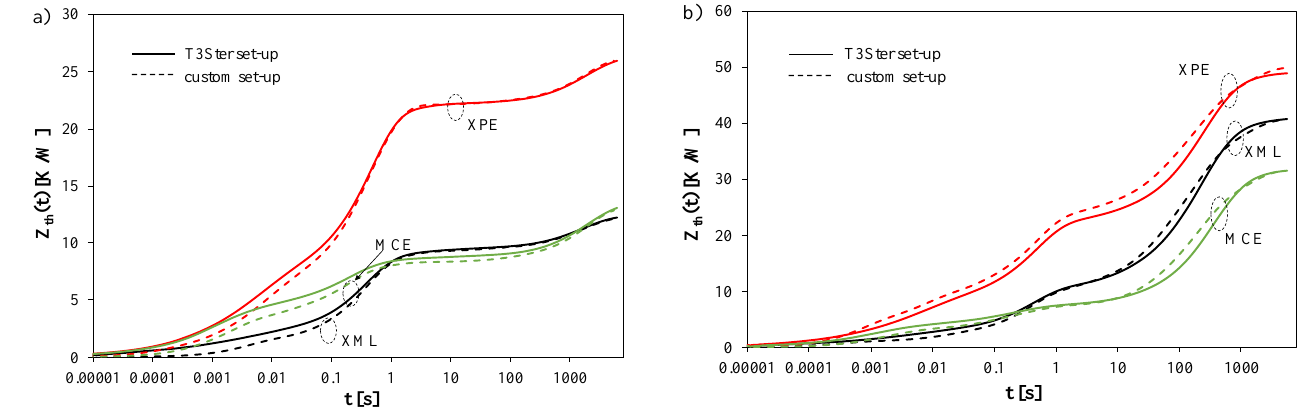
Energies 2021 , 14 , x FOR PEER REVIEW Figure 4. Transient thermal impedances of the tested light emitting diodes (LEDs) measured with the use of both measurement set-ups situated on the heat-sink ( a ) and operating without any heat-sink ( b ). Table 3. Thermal power, optical power, and thermal resistance of the tested power LEDs situated on the heat-sink.